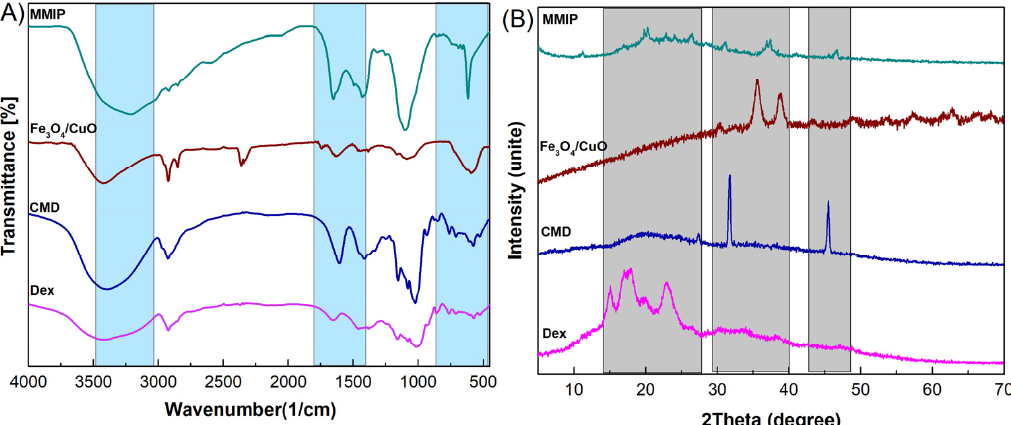
Figure 2. FTIR spectra ( A ) and XRD patterns ( B ) of dextrin (Dex), carboxymethyl dextrin (CMD), Fe 3 O 4 /CuO, and magnetic molecularly imprinted polymer (MMIP).